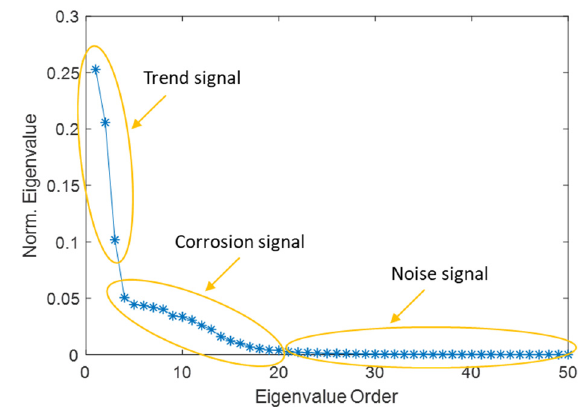
Figure 6. Eigenvalues distribution.